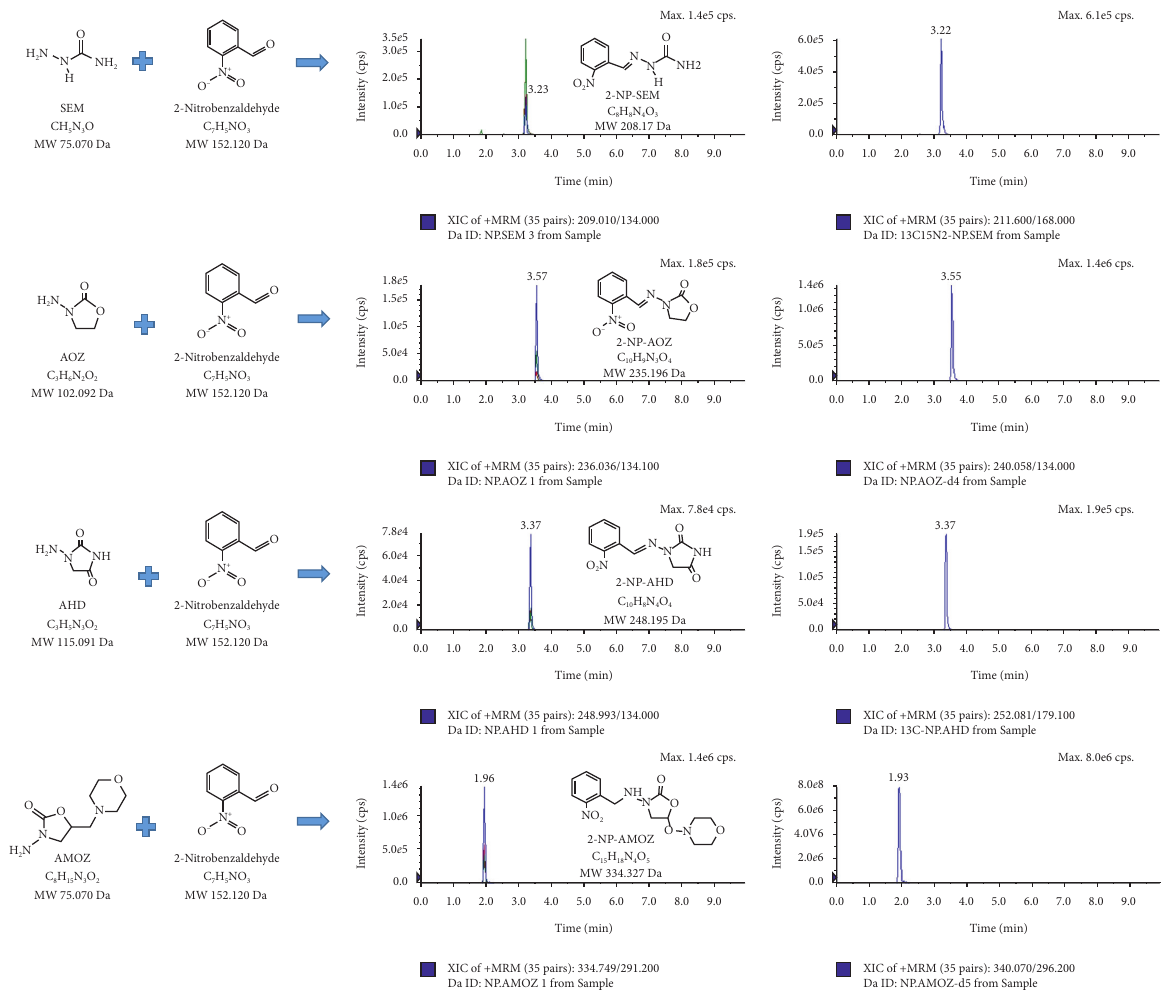
Figure 4: Chromatograms of four NF metabolites (AOZ, AMOZ, AHD, and SEM (10 μ gkg − 1 )) and the ISs in the SSTP